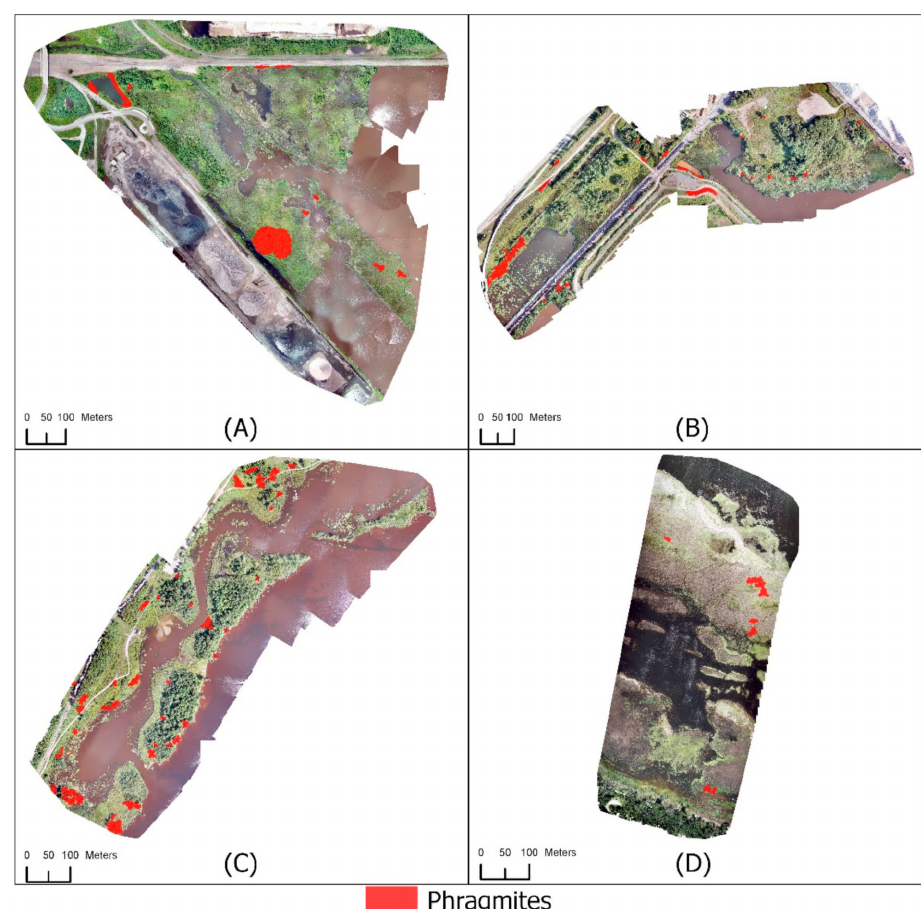
Figure 6. Mapping Phragmites using RGB UAS imagery with a UAS-derived CHM for ( A ) Grassy